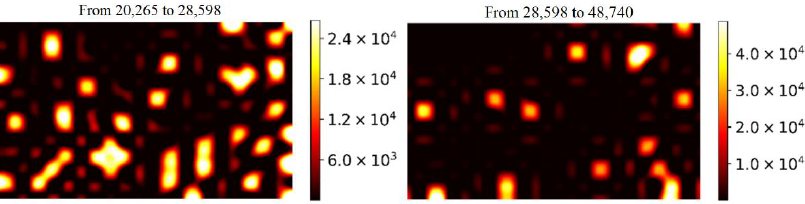
Figure 11. SERS-mapping of the three enhancement zones of 10 mM phthalocyanine molecules adsorbed on substrates with 100 nm diameter NWs.